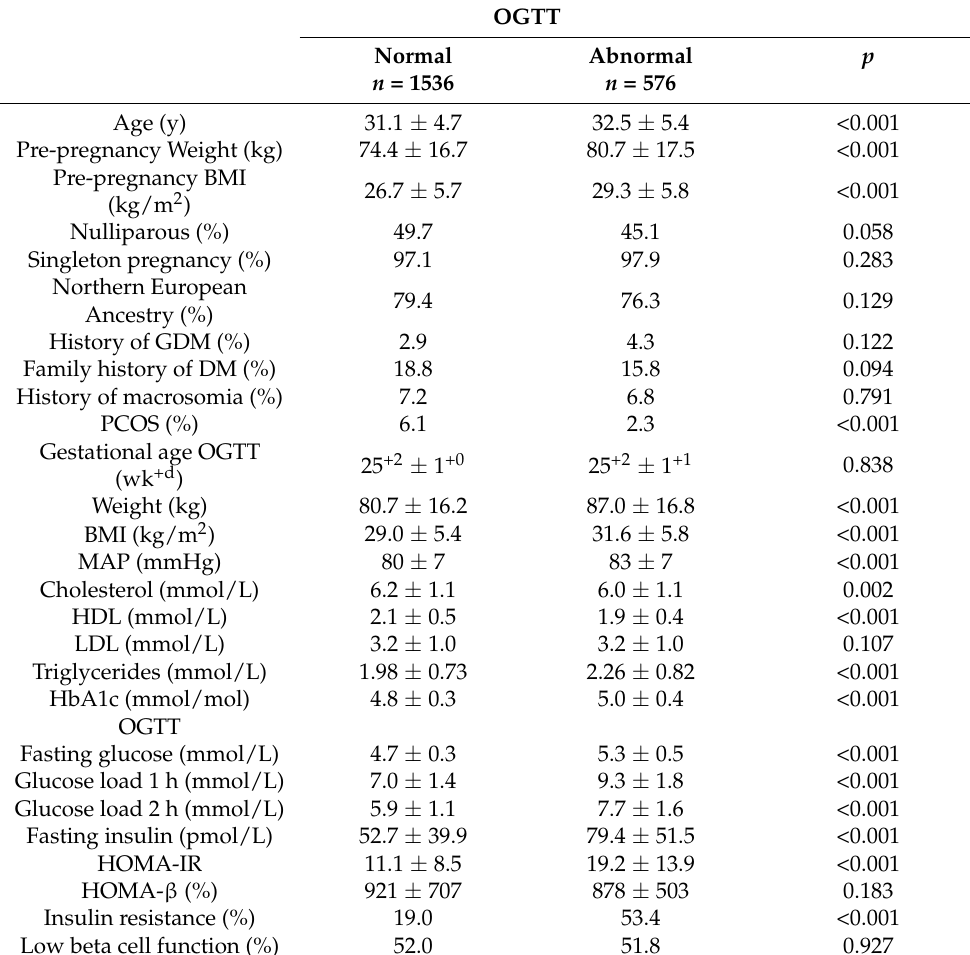
Table 1. Baseline characteristics of the women with a normal or abnormal second-trimester oral glucose tolerance test (OGTT). OGTT Normal Abnormal p n =